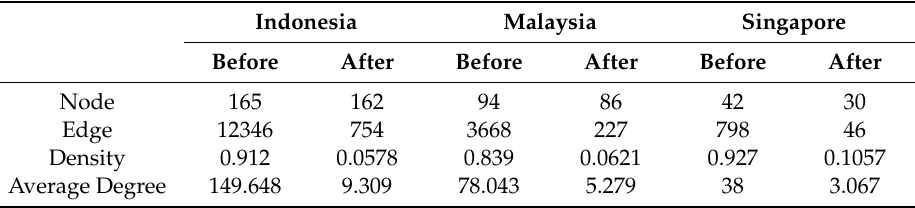
Table 3. Statistics for online news media networks before and after edges removal